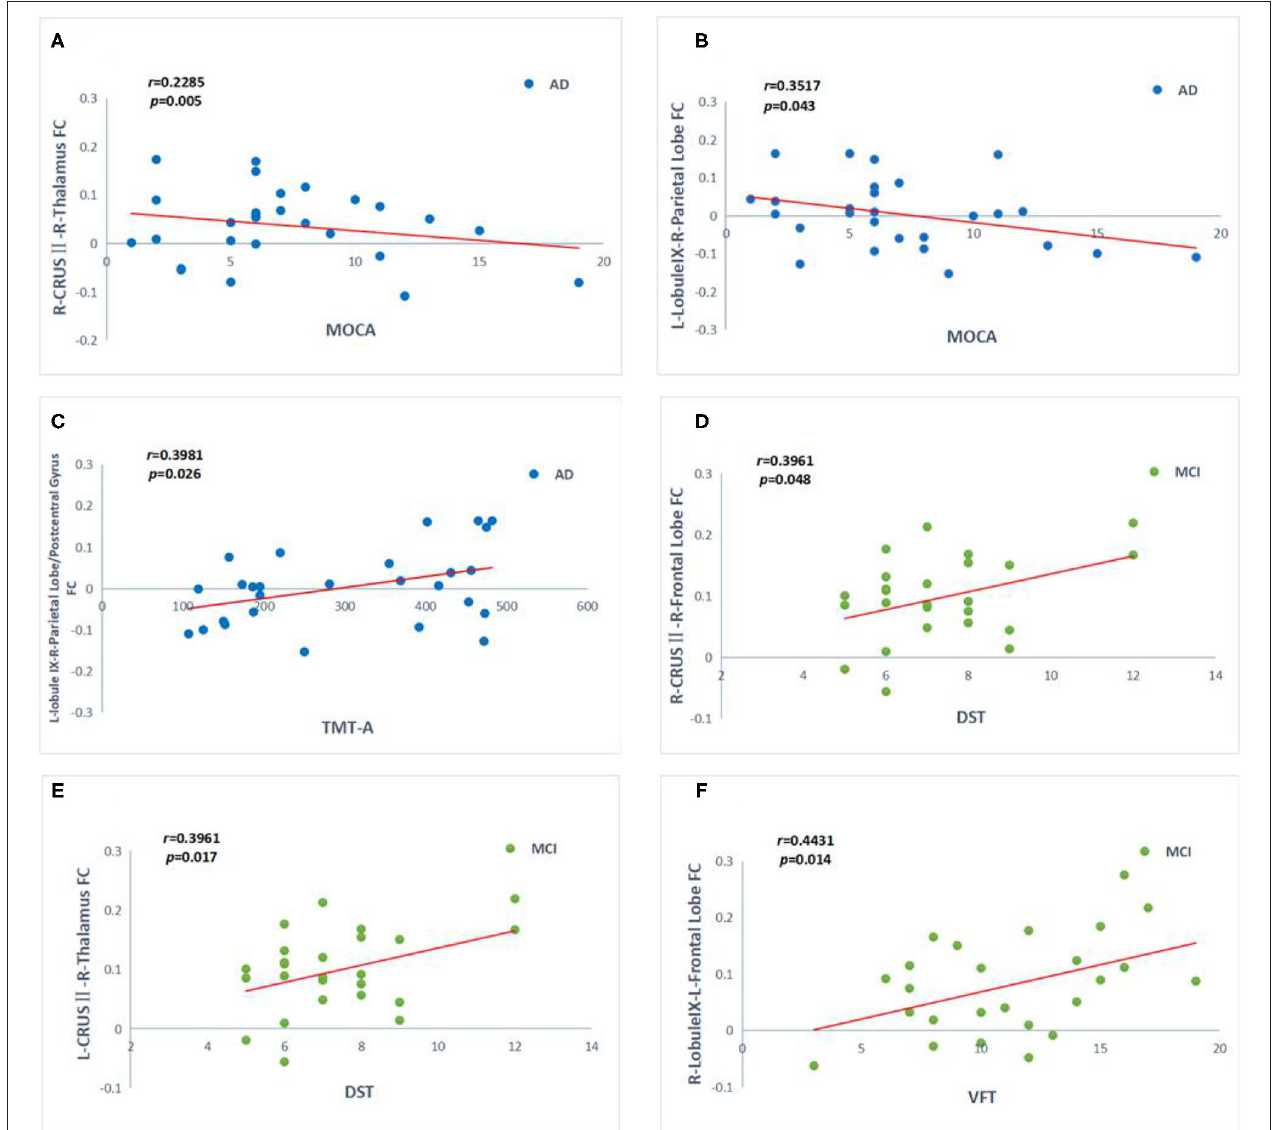
FIGURE 6 | Correlation between the functional connectivity (FC) and cognitive function scores in the AD (blue point) and aMCI (green point) patients. (A–F) Significant correlation between FC changes and cognitive function scales include MOCA, STT-A, DST, VFT in cerebellum crus II and lobule IX (Bonferroni corrected, p < 0.05). Age, gender, and years of education were used to control variables of the results. AD, Alzheimer’s disease; aMCI, amnesic mild cognitive impairment; MOCA, Montreal Cognitive Assessment; DST, Digit Span Test; VTF, Verbal Fluency Test; TMT, Trail Making Test; R, right; L,